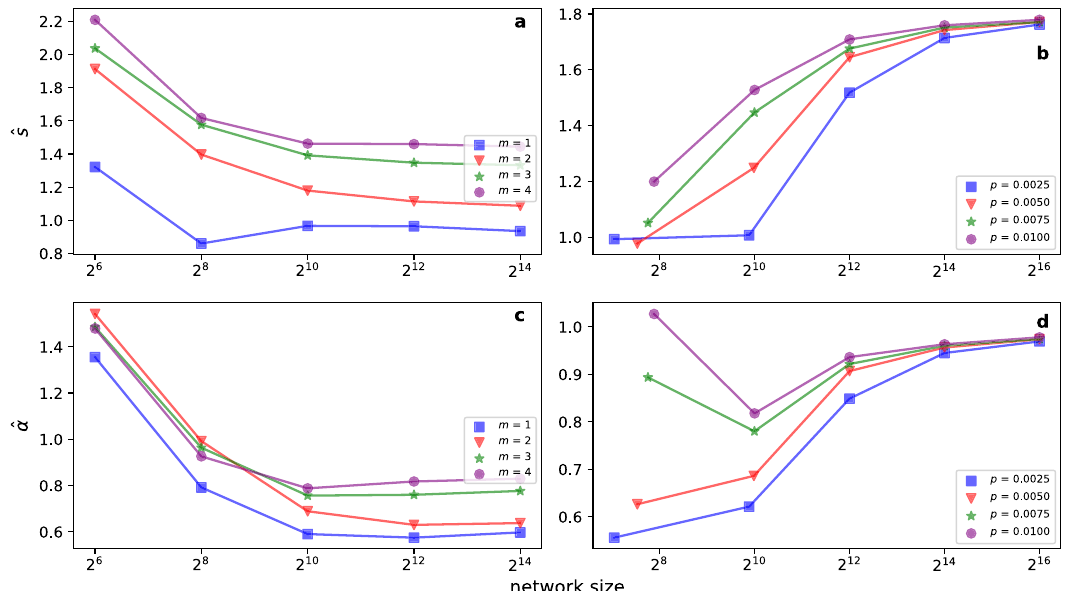
Fig. 4 Dependence in the selection of the embedding dimension from network size and density. a ^ s as a function of the network size N in the BA model. We control the network size and change network density of BA model by choosing different number of edges to attach from a new node to the existing nodes. c ^ α as a function of the network size for the same networks as in ( a ). b , d Same as in panels a and c, respectively, but for the ER model. Here, we control the density of the graphs by tuning the link probability p between different